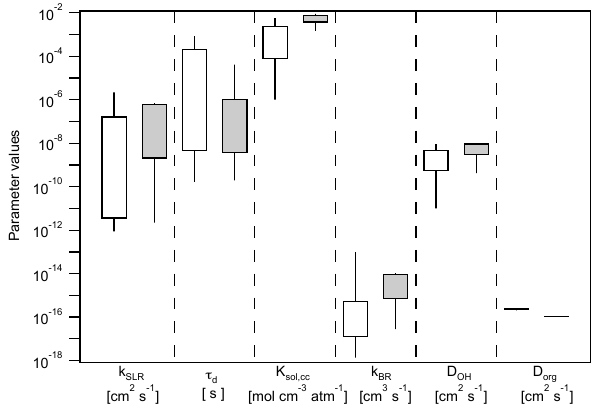
Figure 5. Kinetic parameters for multiphase chemical reactions of OH with levoglucosan (white) and abietic acid (grey) deter- mined by the MCGA method of fitting the experimental data with the KM-GAP model. The ranges of parameters are depicted as a box − whisker plot (the percentiles of 10, 25, 75, and 90% are shown). Reprinted with permission from Arangio et al.